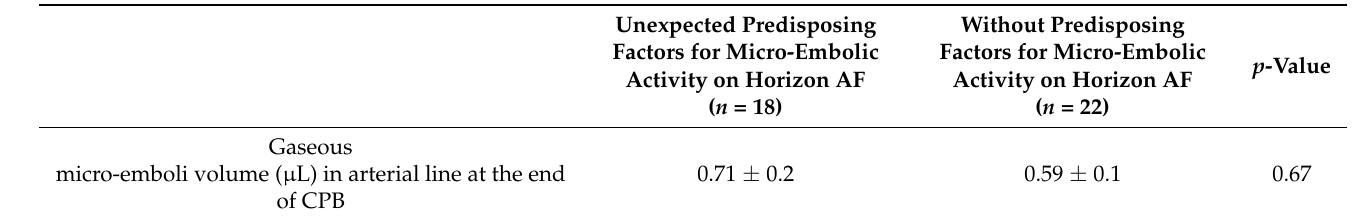
Table 5. Difference for gaseous micro-emboli volume ( µ L) in arterial line at the end of CPBs groups with Horizon AF PLUS.